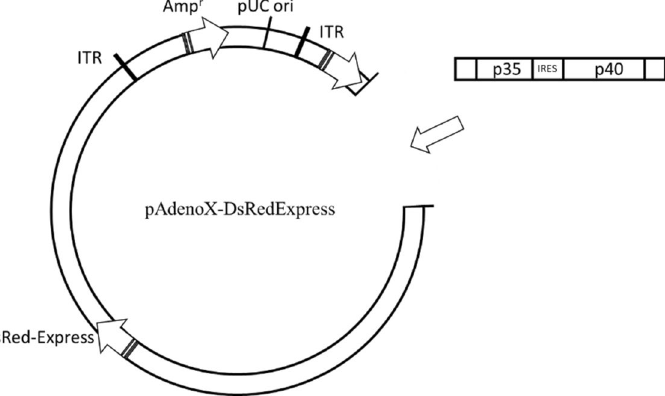
Figure 5. Schematic diagram of the plasmid pAdenoX-DsExpress with the introduced cDNA encoding p35 and p40 IL-12 subunits. The plasmid also contains DsRED marker gene and the gene for ampicillin resistance. The image was drawn using CorelDRAW Graphics Suite X5,